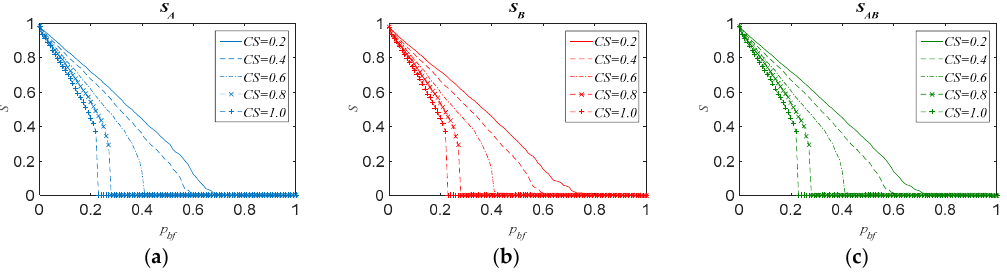
Figure 3. Simulation results of cascading failure of no-feedback interdependent networks with different coupling strength (CS) under bilateral failure (BF), results of one simulation. ( a )cascading failure of subnetwork A with different CS under BF; ( b ) cascading failure of subnetwork B with different CS under BF; ( c ) cascading failure of the entire interdependent networks with different CS under BF.